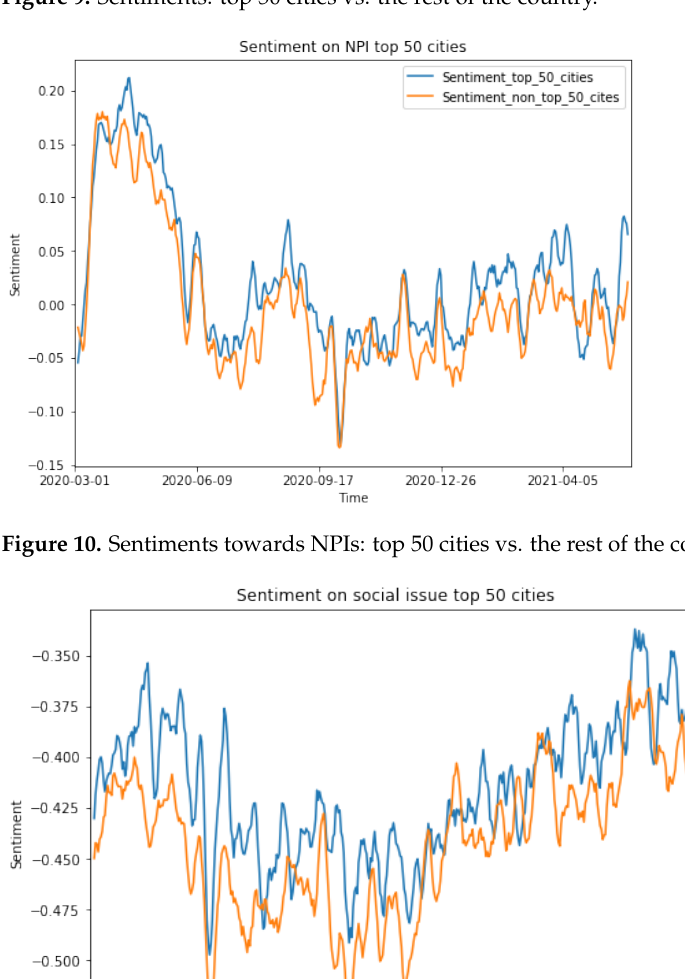
Figure 9. Sentiments: top 50 cities vs. the rest of the country.